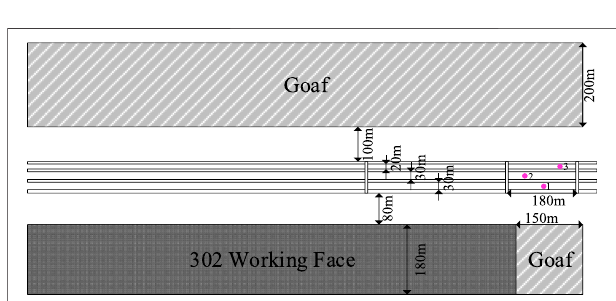
FIGURE 6 | Ground displacement monitoring